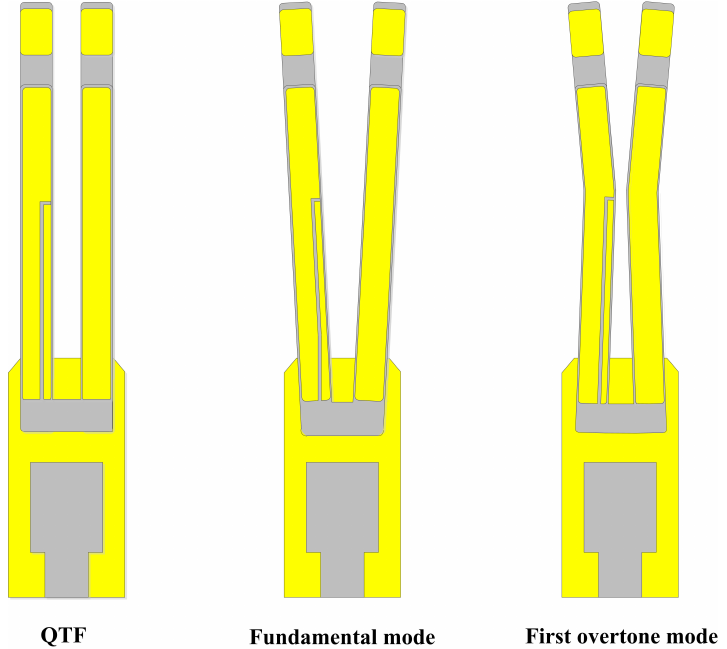
Figure 7. Schematic of the custom QTF, fundamental flexural mode, and the first overtone flexural mode.